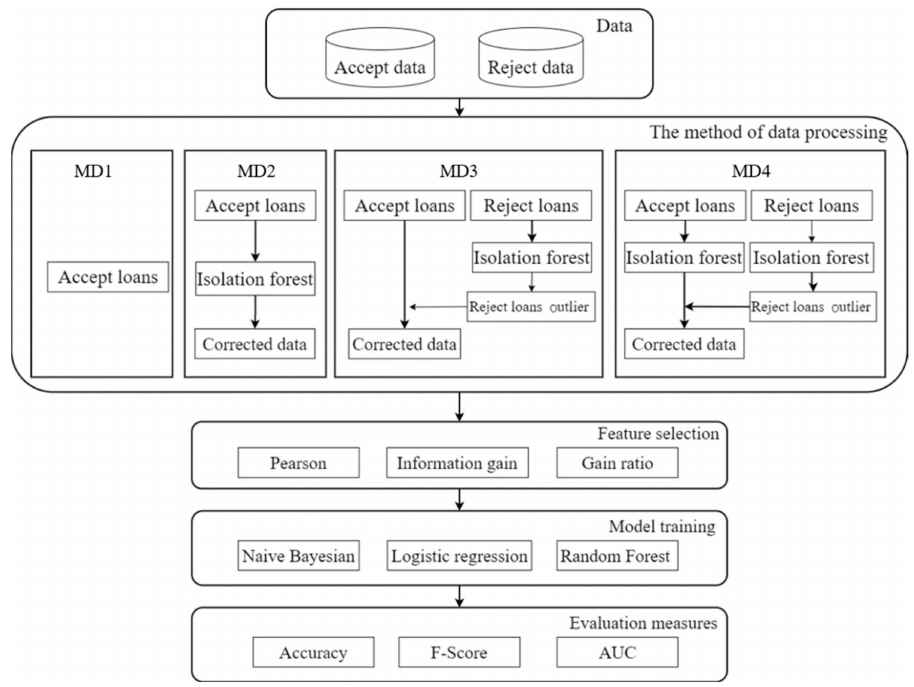
Figure 1. The framework of the global credit-scoring